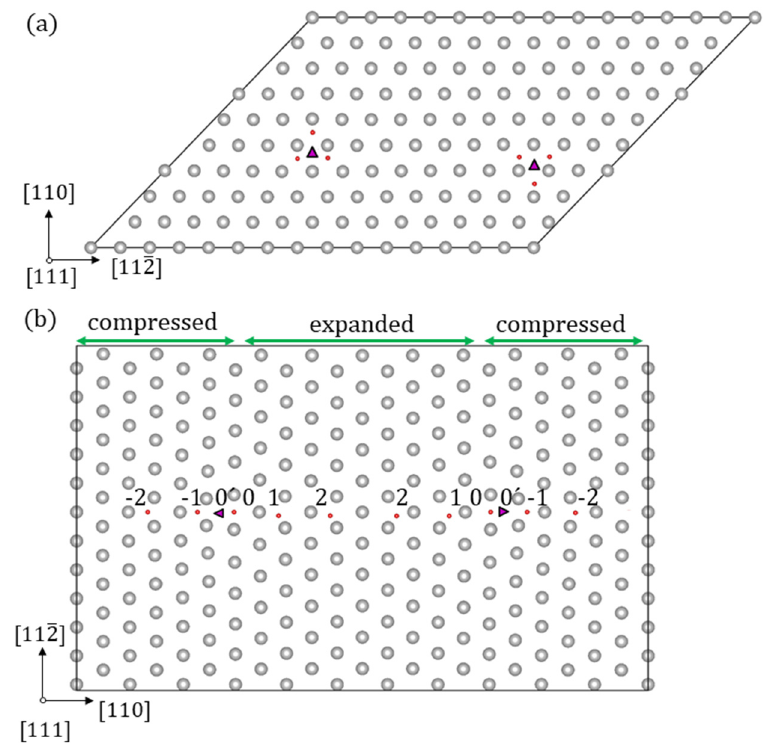
Figure 3. ( a ) ½<111> screw and ( b ) M111 mixed dislocations. The location of the dislocation core is marked as a purple triangle. Initial H atom positons are marked with the red spheres. The digits − 2, − 1, 0, 1, 2 are the numbers of H positions and correspond to Figure 7. 0´ H position is additionally considered one in the dislocation core, but it was found to be less energetically preferable during the atomic relaxation procedure and therefore is not shown in the H profile in Figure 7.